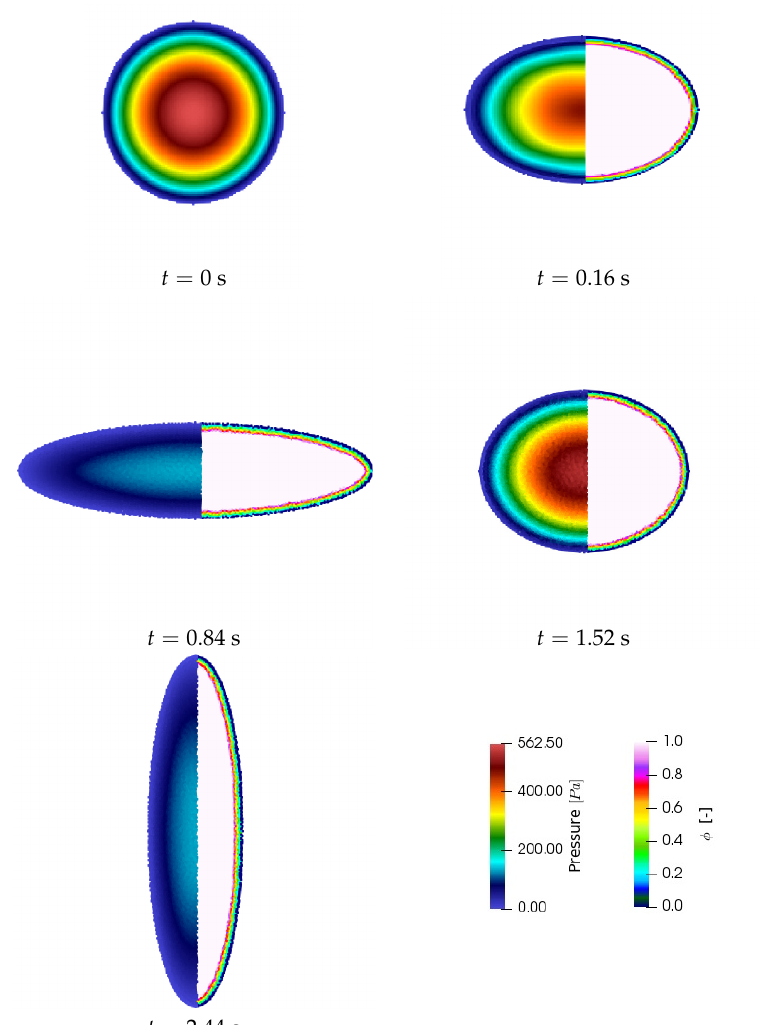
Figure 6. Oscillating droplet under a central conservative force field: Pressure and the dimensionless parameter φ evolution in time. The right half of the droplet is colored by the pressure field, and the left half is colored by the φ paremeter